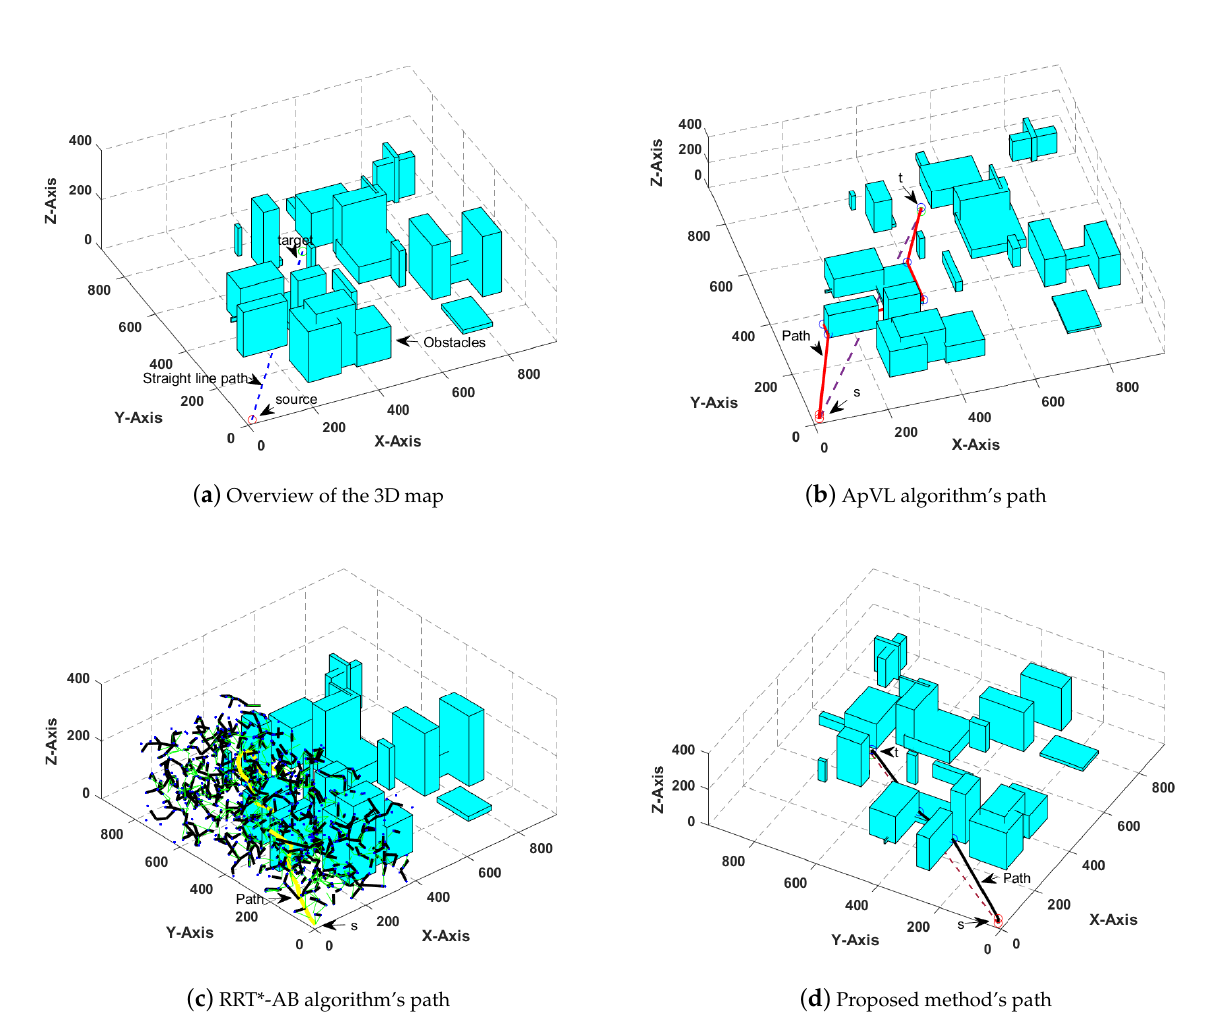
Figure 8. Example of the paths produced by the proposed method, ApVL, and RRT*-AB